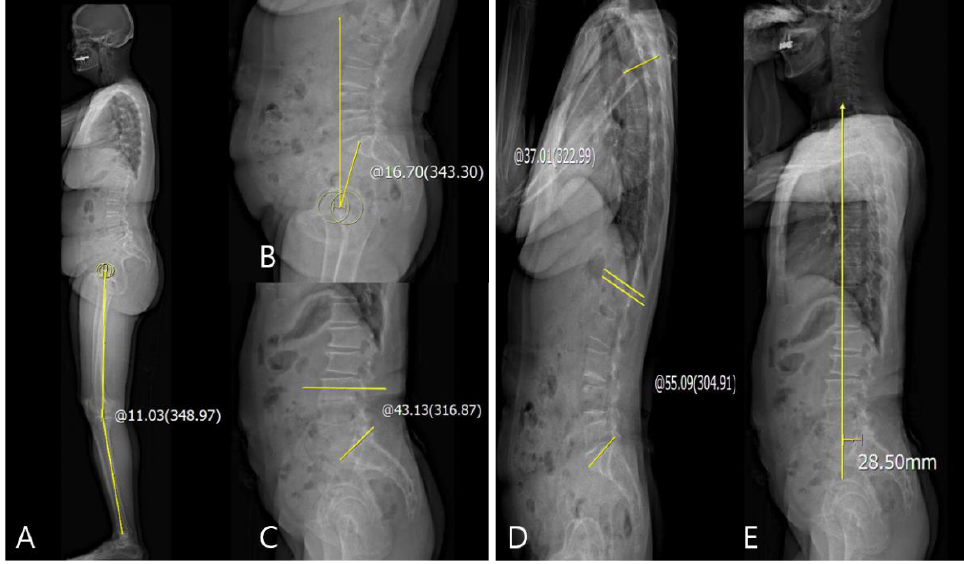
Figure 2. ( A ) Measurement of sagittal HKA angle: +11.03°; ( B ) measurement of PT: +16.70°; ( C ) measurement of SS: +43.13°; ( D ) measurement of TK and LL: +37.01° and +55.09°, respectively; ( E ) measurement of sagittal SVA: +28.50 mm.